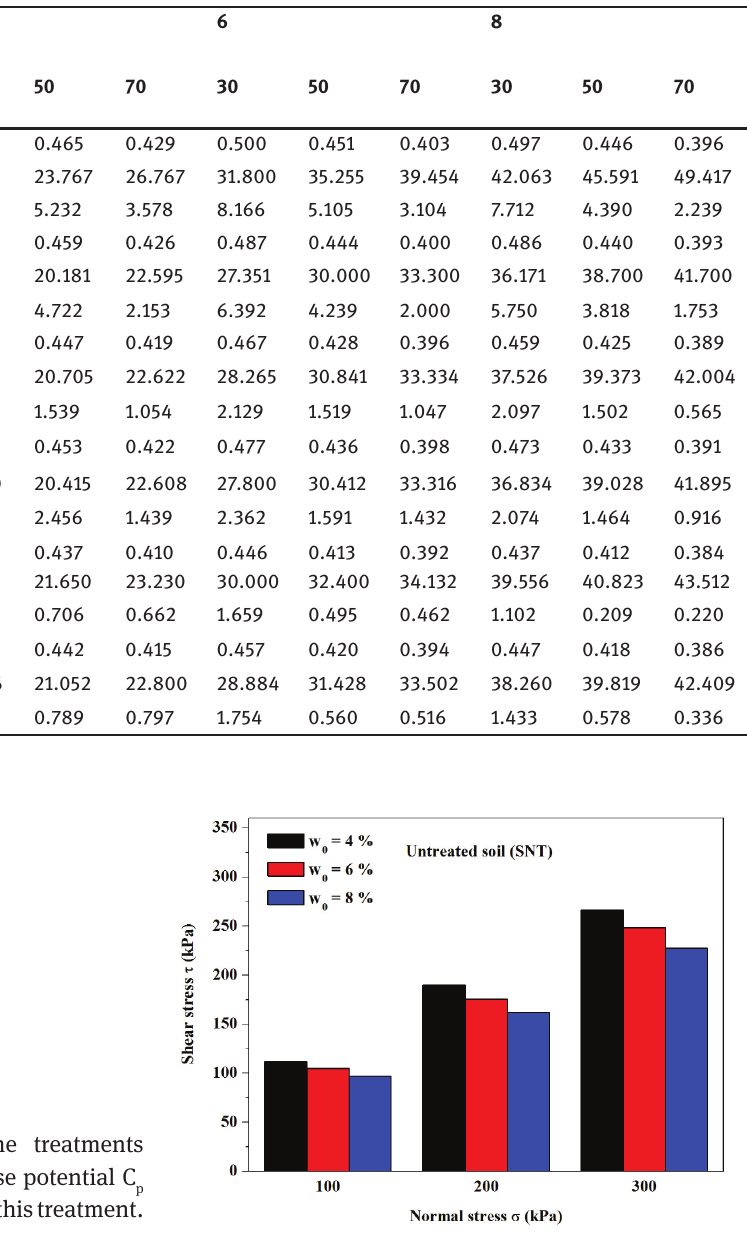
Figure 4: Variations of tangential stresses of control soil